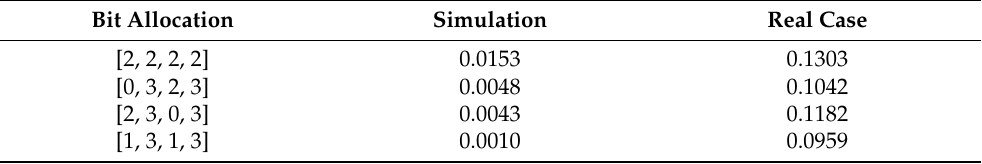
Table 3. Performance (BER) of simulation and physical case with different 4-channel